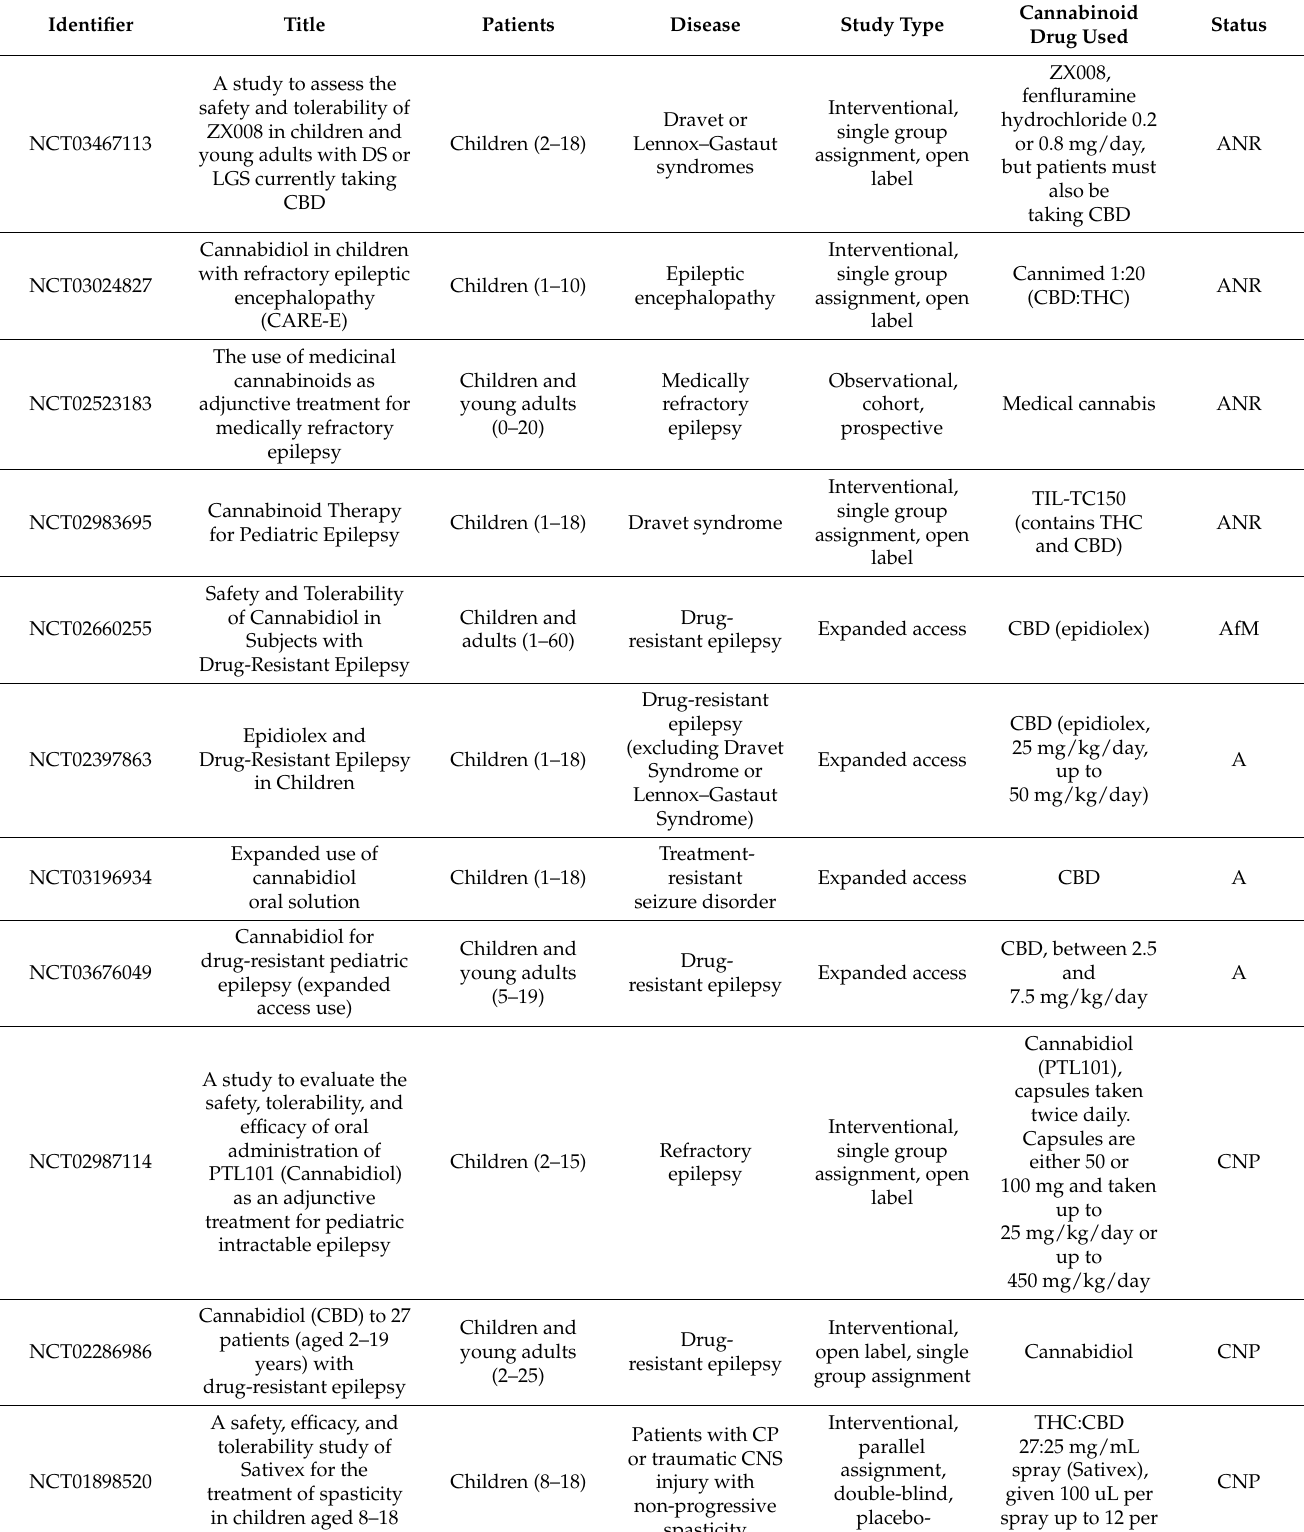
Table 2. Currently ongoing or unpublished clinical trials involving pediatric patients and some form of cannabinoid